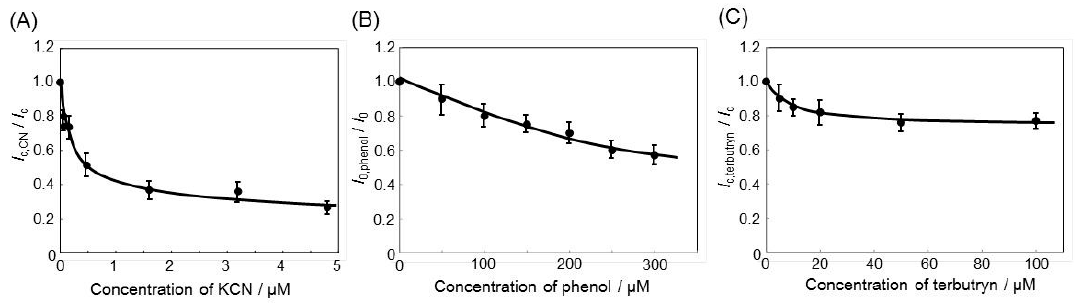
Figure 4. Effect of KCN ( A ) phenol; ( B ) or terbutryn; ( C ) concentration on the photocurrent ( I c ).